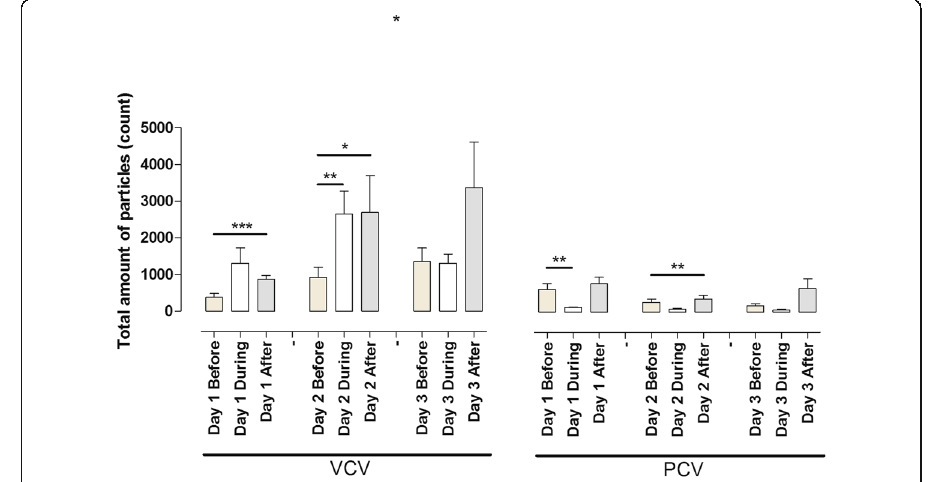
Fig. 3 All animals underwent recruitment manoeuvre (RM) twice daily starting on day 1 until day 3. The total accumulated particle count was measured by PExA 3 min before RM, 1 min during the RM and 3